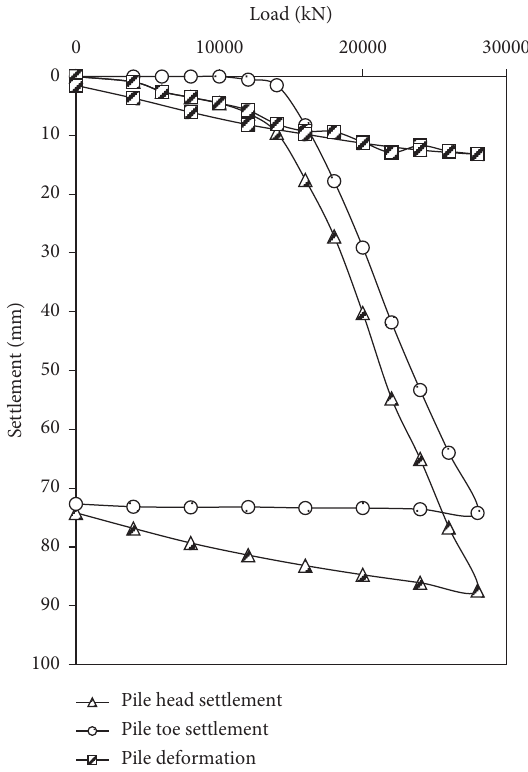
Figure 8: Load-settlement curves of P12.